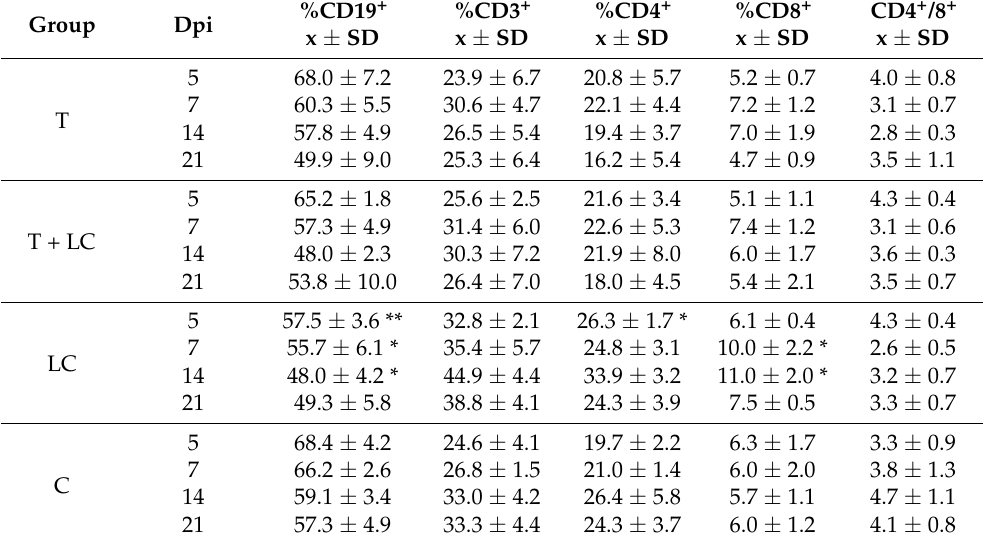
Table 1. Percentage of B splenocytes (CD19 + ) and T splenocytes (CD3 + , CD4 + , CD8 + ) in the mice infected with T. spiralis (Group T), infected with T. spiralis and receiving LC (Group T + LC), uninfected with T. spiralis and receiving LC (Group LC), and uninfected mice (control) (Group C). Mean values ( n = 6) and standard deviations are presented. p < 0.05 *, p < 0.01 **.